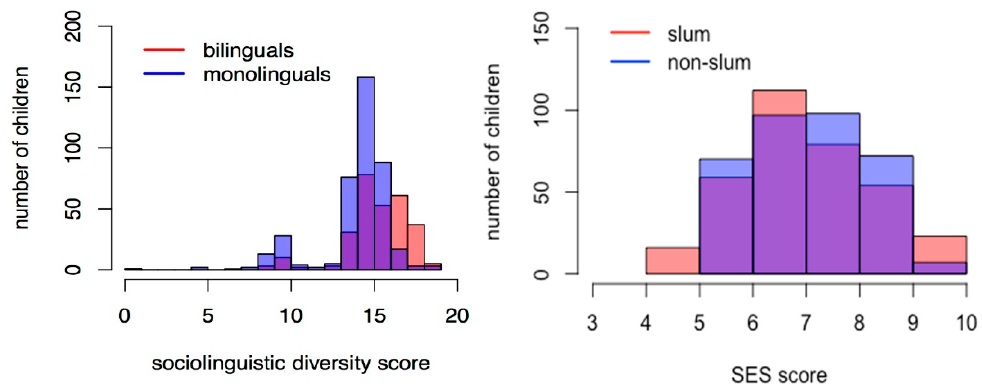
Figure 2. Distribution of the scores of sociolinguistic diversity for bilinguals and monolinguals ( left graph) and socio ‐ economic status (SES) for children from schools in slum and non ‐ slum areas ( right graph). Purple areas reflect the overlap between the two groups on the sociolinguistic diversity or SES scores.